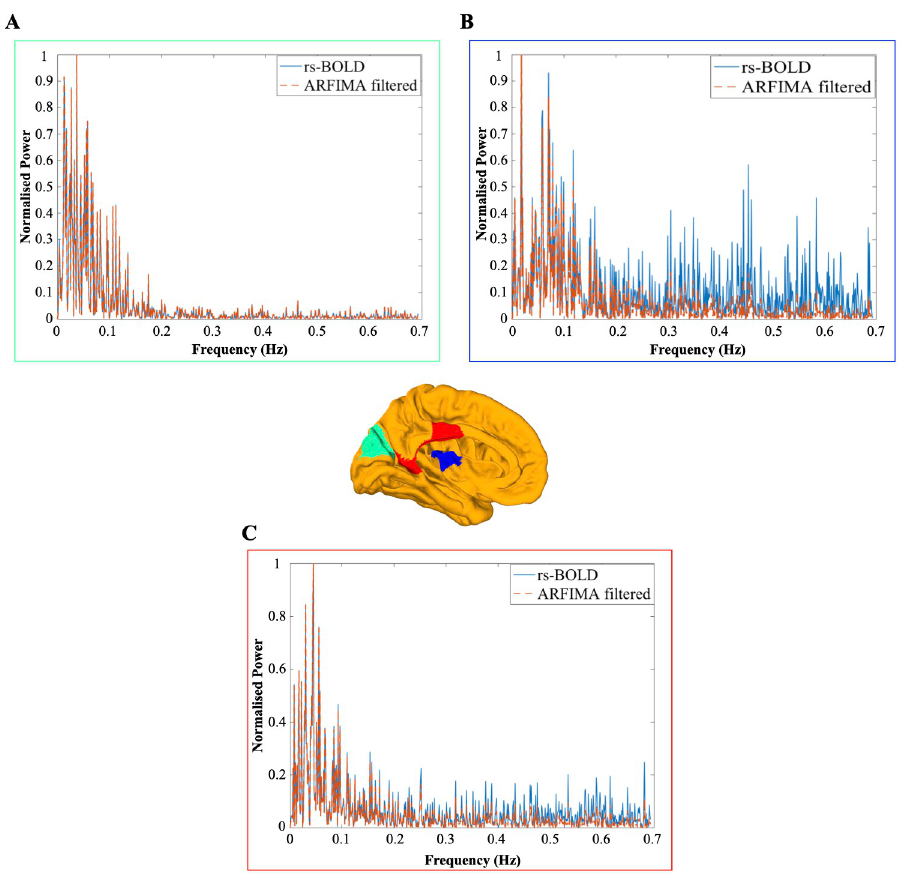
Fig 5. Normalised power spectrum of the unfiltered and filtered resting-state BOLD signal for three different ROIs. The color-coded power spectrum plots, i.e. cyan and dashed orange, represent the plots of the resting-state BOLD signal and ARFIMA (1, d , 0) filtered BOLD signal respectively of one of the subjects. The location of each of the three ROI is presented in the brain overlay (in the centre) in different colours. The power spectrum of the corresponding ROI is outlined in the same colored box. (A-C) Normalised power spectrum of the resting-state and ARFIMA filtered BOLD signal corresponding to the ROI: 7 lying in the visual peripheral brain network (a green colored region in brain), ROI: 11 in the somatomotor auditory network of the brain (a blue colored region in the brain) and ROI: 37 in control network (a red colored region), respectively, is shown. The filter used in each of the case is: ARFIMA (1, 0.7, 0) (in A), ARFIMA (1, 0.3, 0) (in B) and ARFIMA (1, 0.5, 0) (in C).